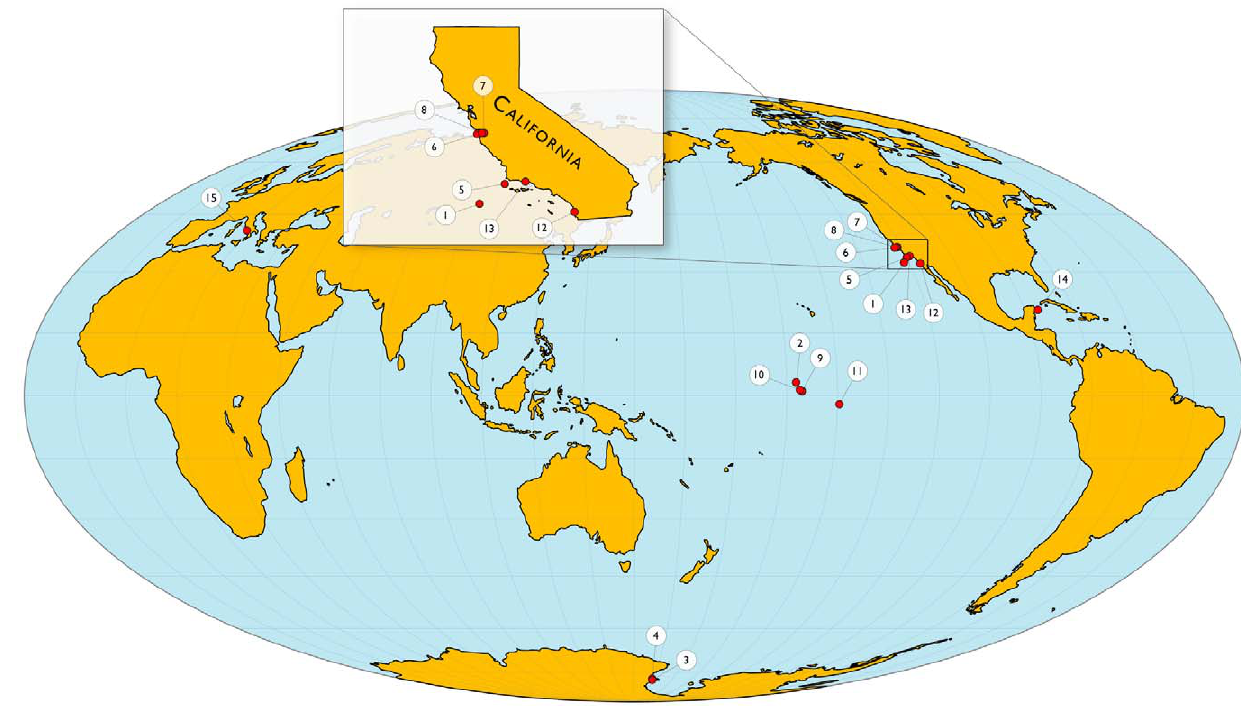
Figure 1. Map of pH sensor (SeaFET) deployment locations. See Table 1 for details regarding deployment locations.